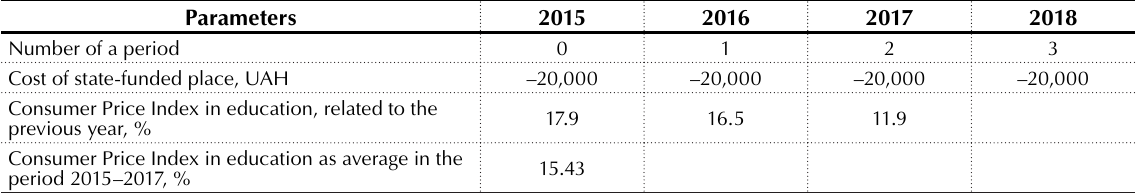
Table 2. The cost of a state-funded place per single applicant of educational level “Bachelor” (funding per 1